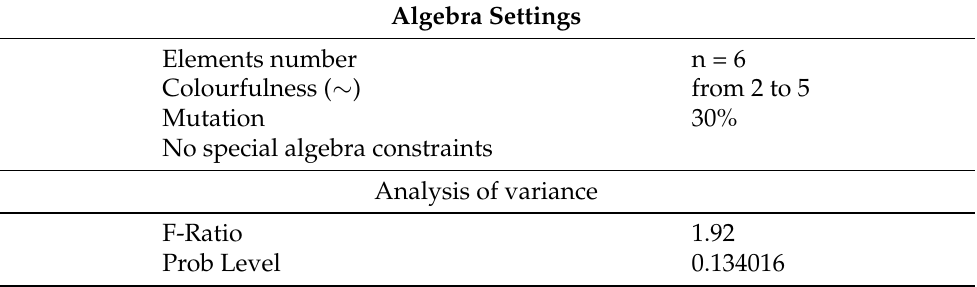
Table 2. Experiment no.